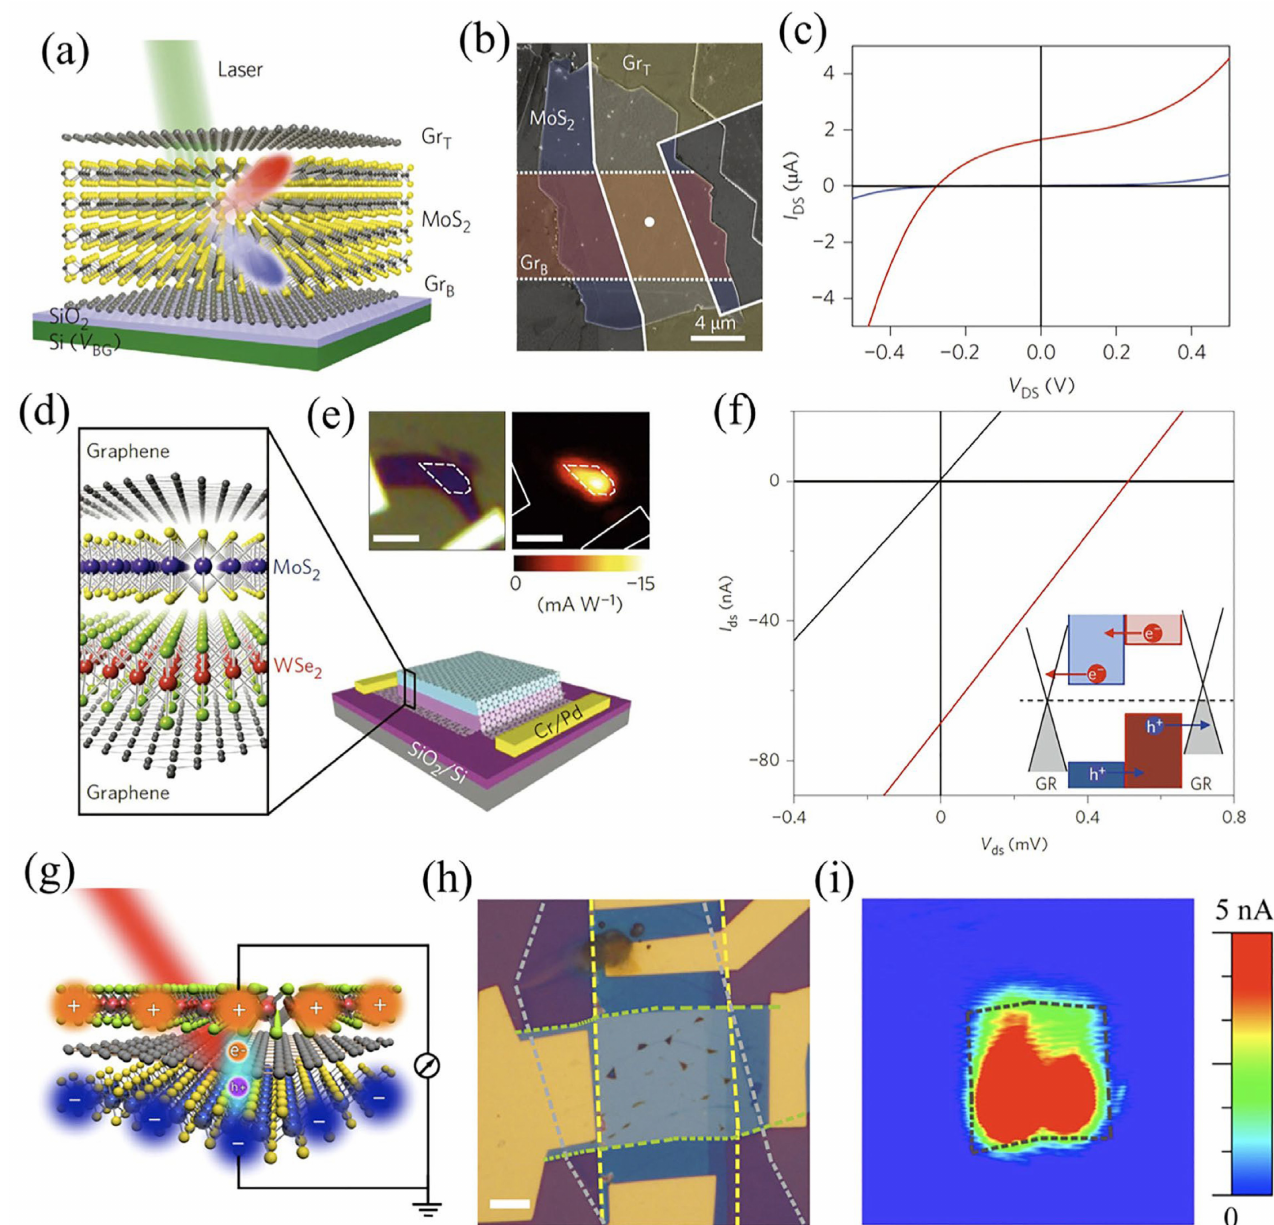
Figure 12. ( a ) Multilayer MoS 2 sandwiched among graphene electrodes (edge view). ( b ) The graphene layer at the bottom graphene (red), middle (blue), and top MoS 2 layer (yellow) are each falsely colored in the SEM photograph of the device. ( c ) I–V behavior of the vertical device. Adapted with permission from Ref. [169]. Copyright 2021, Nature Publishing Group. ( d ) Representation of graphene sandwiched between an MoS 2 /WSe 2 junction. ( e ) Photocurrent map for the correspond- ing junction (V ds = 0 V) and an optical photograph of a single-layer p–n junction device (1L–1L) sandwiched between a graphene electrode. ( f ) I–V curves of the device publicized in the figure restrained in the dark (black) and under 532 nm laser excitation (red). Adapted with permission from Ref. [153]. Copyright 2014, Nature Publishing Group. ( g ) Illustration of photodetector based on p–g–n heterostructure. ( h ) Optical microscopic view of the device. ( i ) Photocurrent mapping from the narrow p–g–n junction at V ds = 0 V. Adapted with permission from Ref. [171]. Copyright 2016, American Chemical